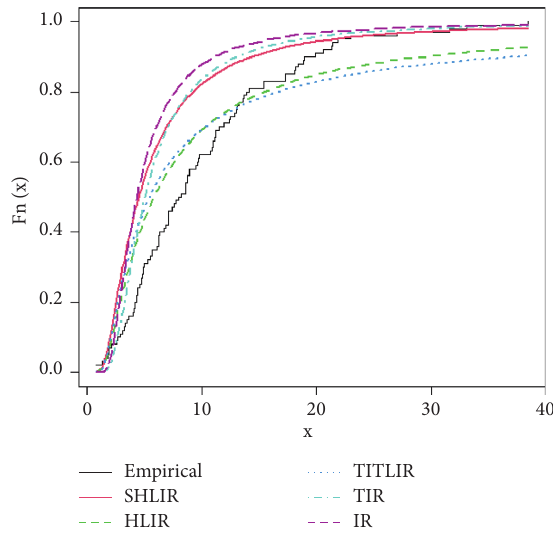
Figure 4: Fitted CDFs of models for data II. Table 3: The MLE and SE of the model parameters for data I.